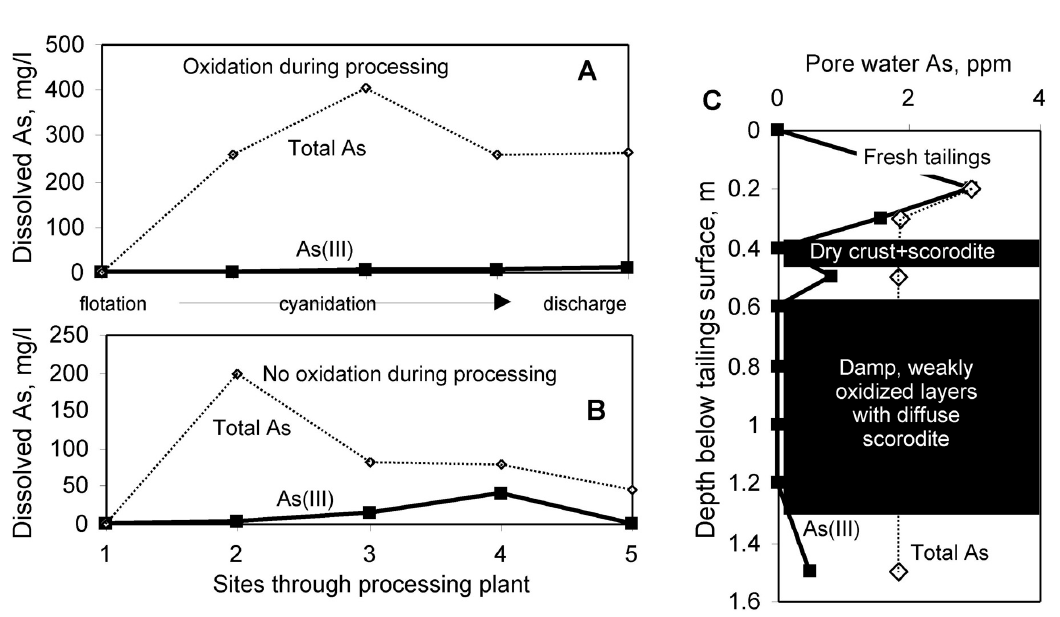
FIGURE 5. Inorganic speciation of dissolved As in the Macraes mine processing plant and tailings: (A) samples through the processing plant in which the system is oxidised with oxygen gas to enhance Au recovery; (B) samples through the processing plant without oxidation; (C) profile through concentrate tailings rich in arsenopyrite (see text for